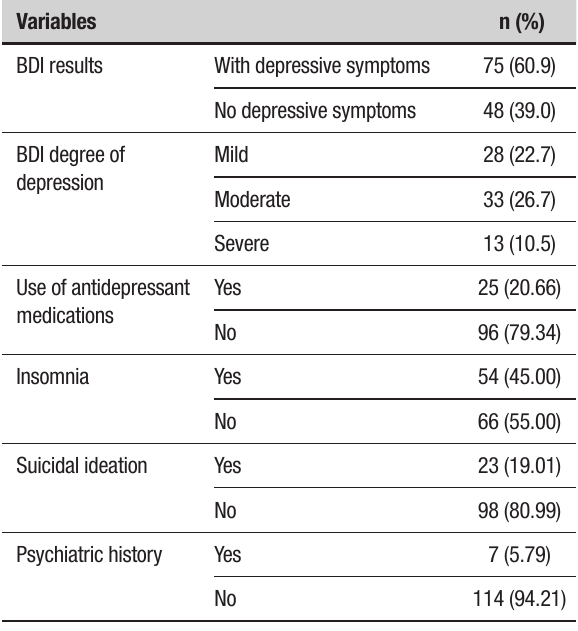
Table 1. Depressive symptom profile in patients with PD.